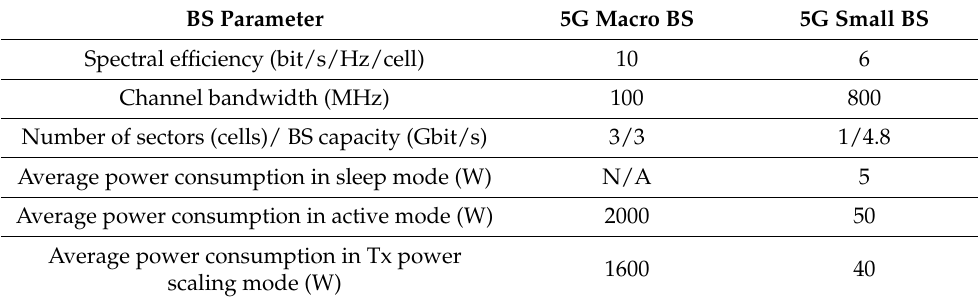
Table 2. Operating parameters of different BS types used in the analyses. BS Parameter 5G Macro